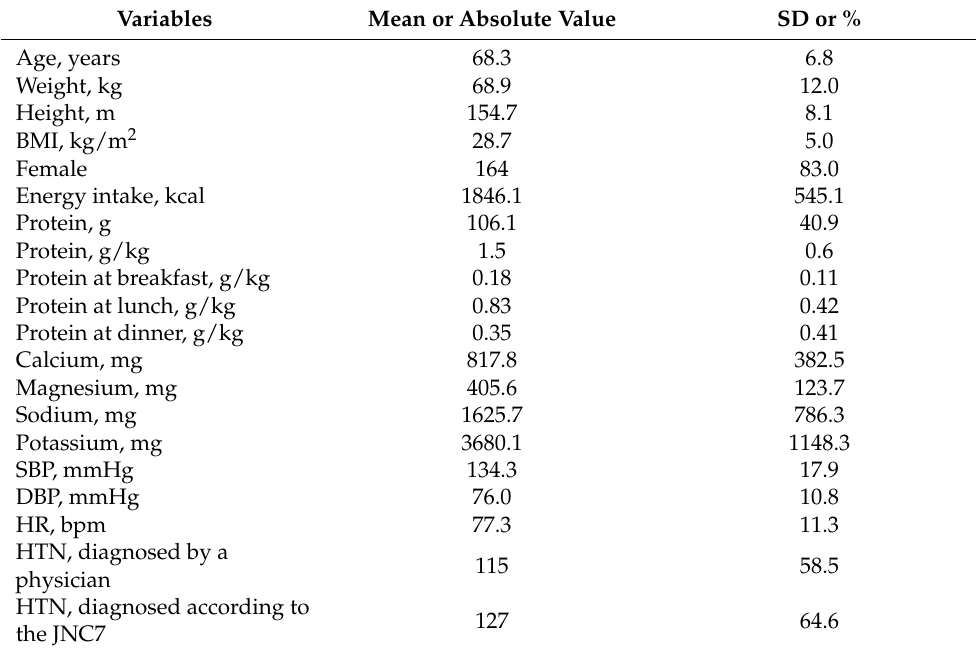
Table 1. Characteristics of study participants (n = 197).